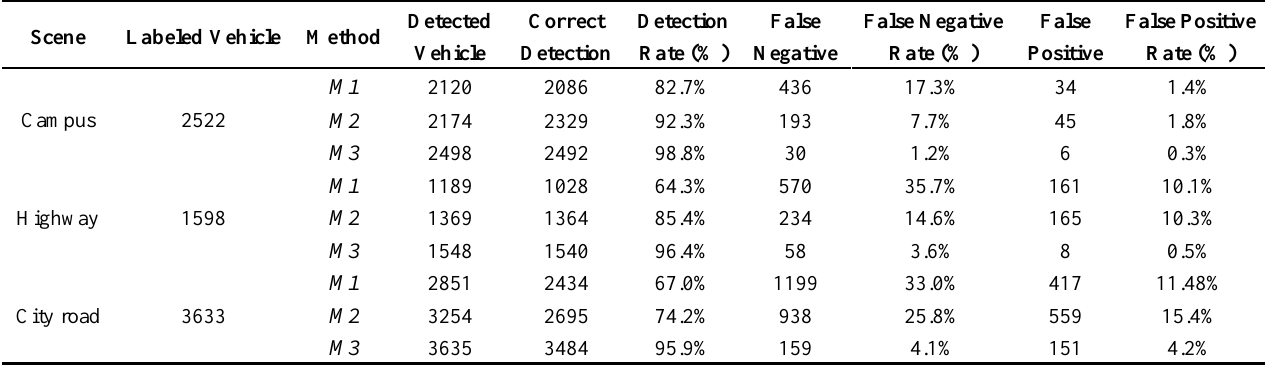
Table 2. Comparison of the performance of different